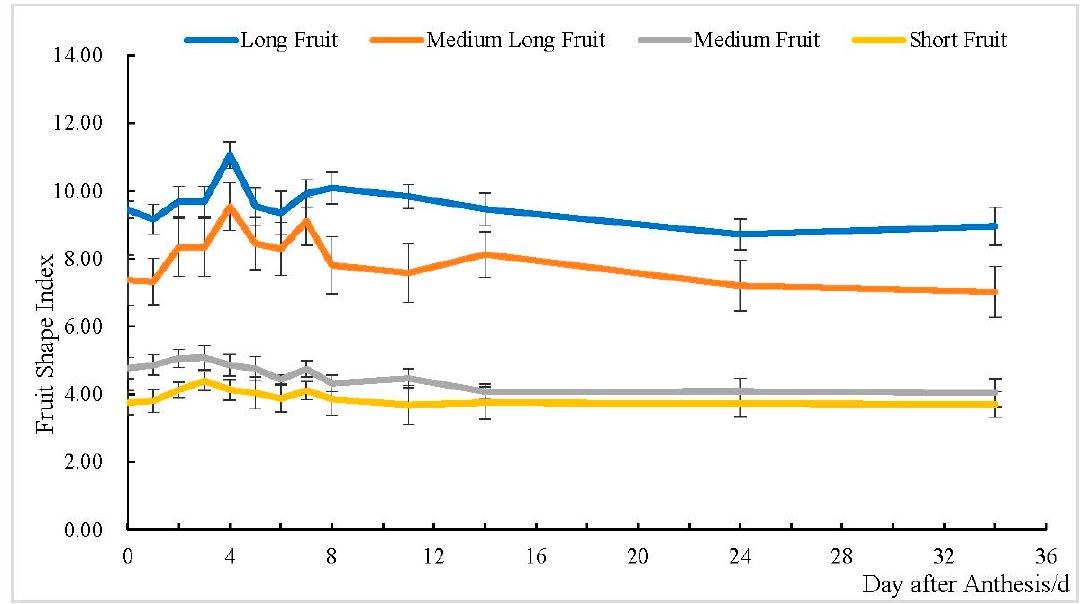
Figure 2. The dynamic changes of fruit shape index in four types of cucumber fruits during the fruit developing process.